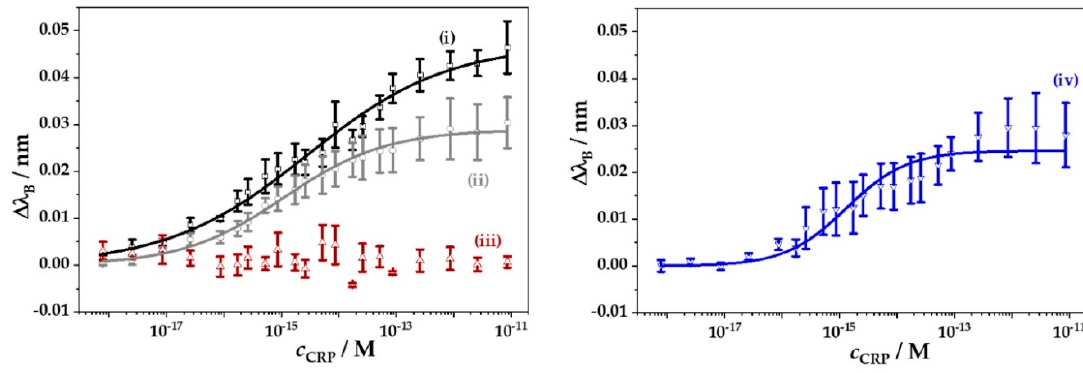
Figure 14. The Bragg wavelength shift ∆λ B of biofunctionalized eFBG fibers as a function of CRP concentration (i) without any interfering substances (black), (ii) in the presence of the interfering substances urea (1.8 g/L) and ascorbic acid (1.8 g/L) (grey), (iii) without fiber coupling of the CRP-specific aptamer and any interfering substance (brown), and (iv) in presence of diluted CRP deficient human plasma (blue). Data were fitted to the Langmuir–Freundlich isotherm. Reproduced under the terms